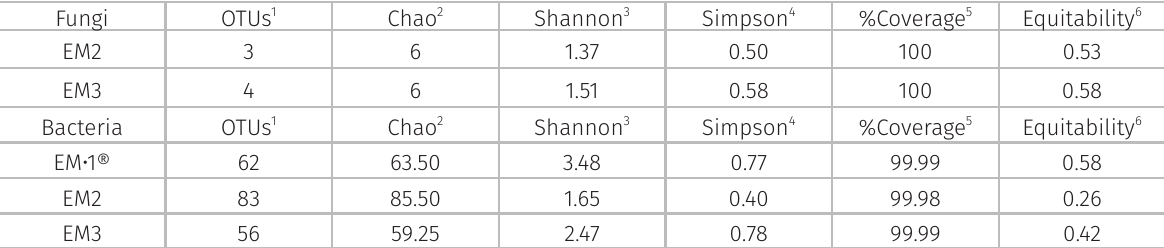
Table II. Total Fungi and Bacteria OTUs, richness of species, estimates of diversity and equitability.